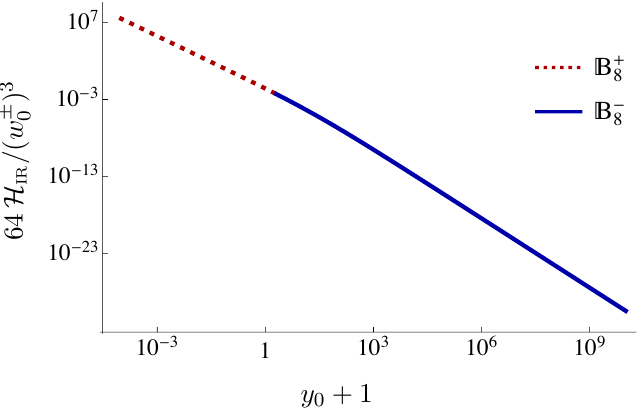
Figure 5 . Values of the parameter H